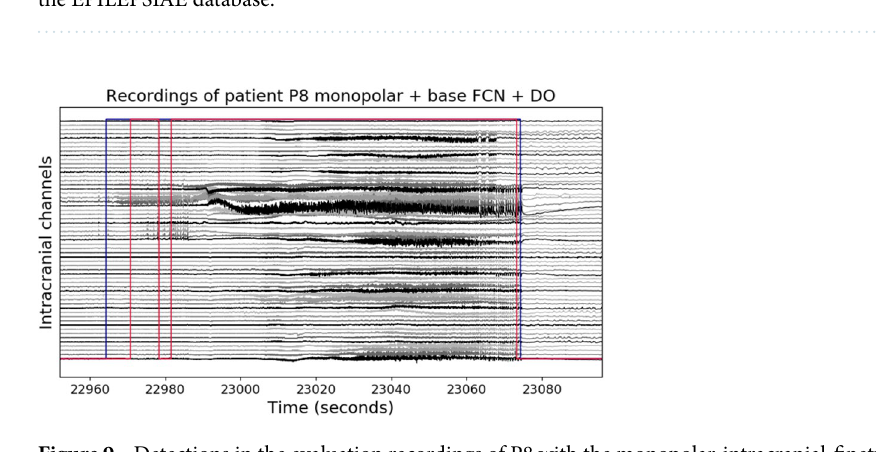
Table 2. Evaluation metrics using the First Seizures configuration with intracranial data from three patients of the EPILEPSIAE database.